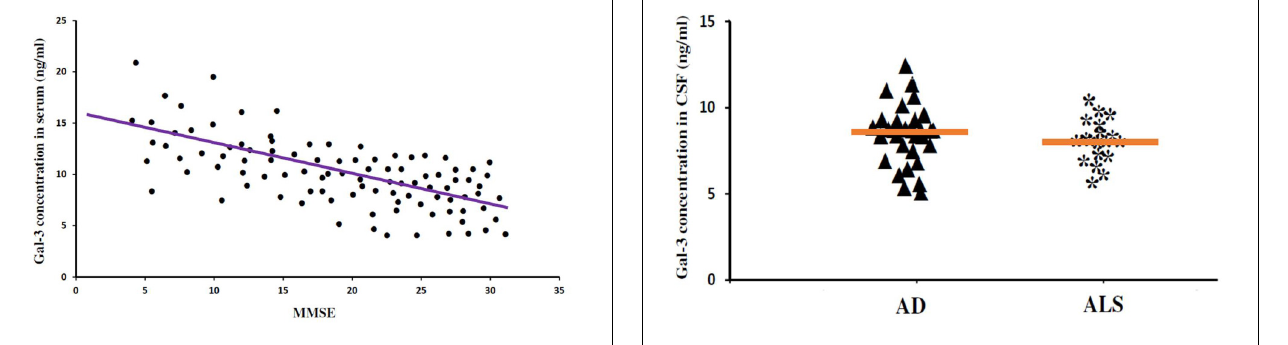
FIGURE 8 | The concentrations of Gal-3 in CSF (ng/mL) of AD and ALS. There was no significant difference in the concentrations of Gal-3 in CSF of AD and ALS patients (AD vs. ALS [mean ± SD] 8.37 ± 2.79 vs. 7.92 ± 2.56 ng/mL; P = 0.734).